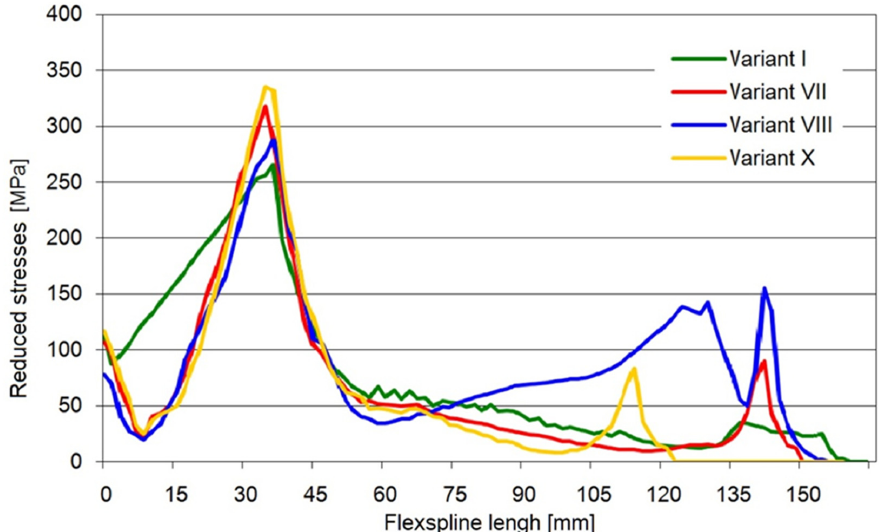
Figure 16. Stress values in the longitudinal section through the major axis of the wave generator for selected long variants of the flexspline.